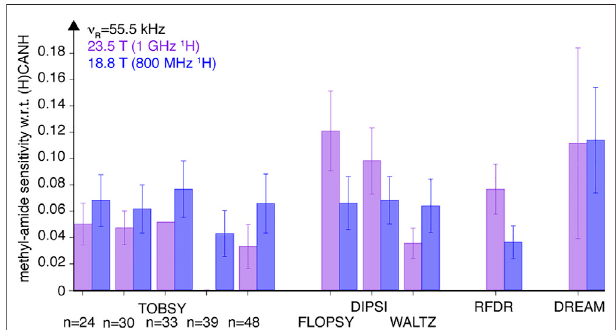
FIGURE 10 | Ef fi ciency of various 13 C mixing schemes compared between 18.8- and 23.5-T fi elds [ purple (left) and blue (right) bars, respectively]. Presented are sensitivity of correlation peaks in 3D (H)C(CC)(CA)NH spectra of SH3 protein obtained at 55.5 kHz MAS, with respect to sensitivity of correlations in (H)CANH experiment at both conditions. Relative sensitivity is averaged equally over 24 cross-peaks of Val, Leu, and Ile residues. Data for TOBSY C9 1 39 were not collected at 23.5 T fi eld. The error bars re fl ect the standard deviation (scatter) of values observed for a set of residues, not the experimental error of average